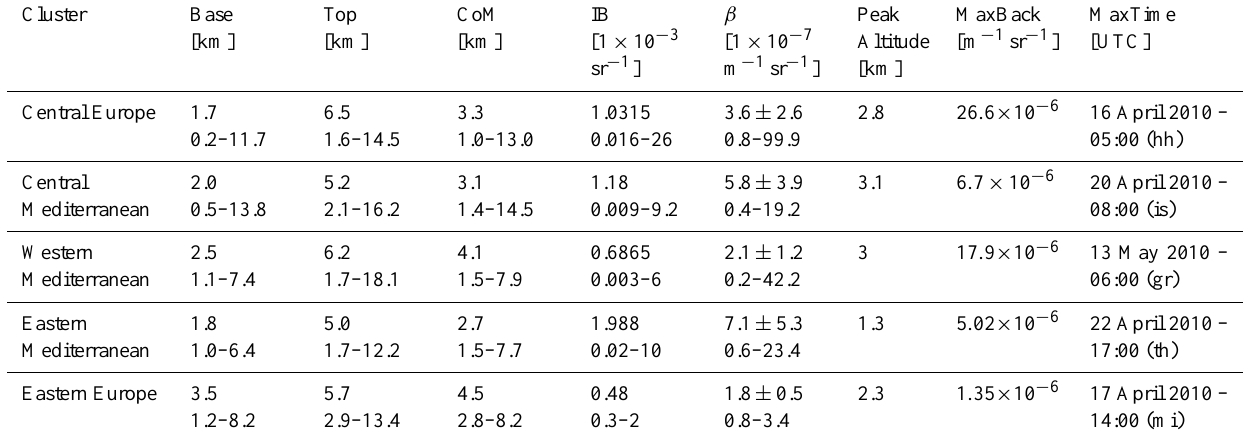
Table 2. Geometrical and optical properties of the volcanic layers for each of the clusters: median value and minimum-maximum range value of base, top, center of mass (CoM), integrated backscatter (IB) and backscatter ( β) at 532nm are reported together with the maximum backscatter value (peak value) with corresponding altitude, location, and